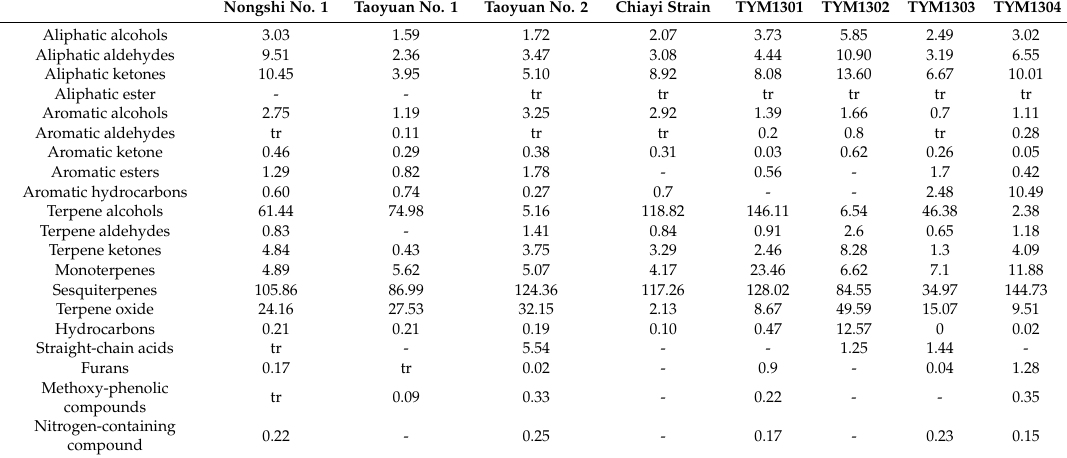
Table 6. Concentrations of chemical groups of overall extracted Hsian-tsao analyzed using SDE. Nongshi No. 1